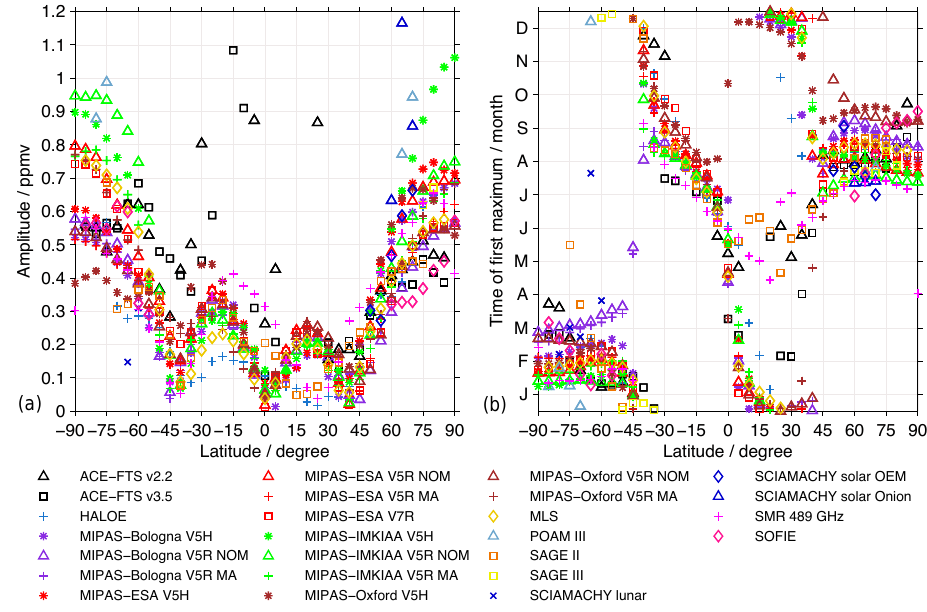
Figure 4. The annual variation as observed by the individual data sets at the 1hPa pressure level over the entire latitude